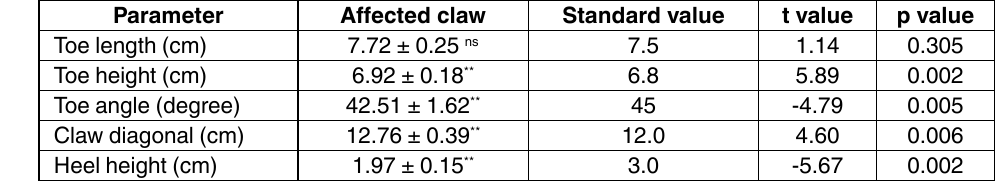
Table. 1. Claw dimensions (Mean ± SE ) of affected claws in animals with sole lesions (n=18)